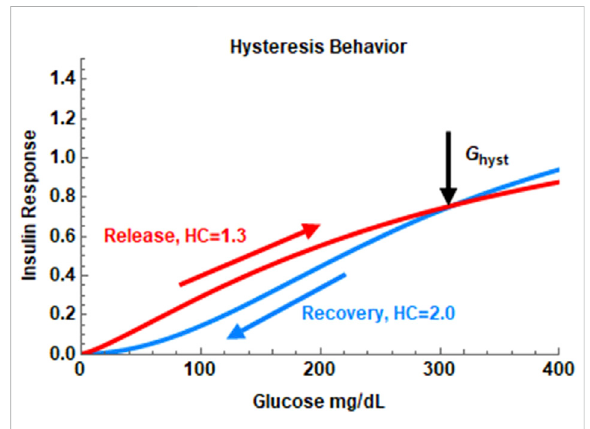
FIGURE 1 The hysteresis behavior of the insulin dose-response in Model 2. In this example, the Hill coef fi cient, h, is set at 1.3 during the insulin release phase and set at 2.0 during the recovery